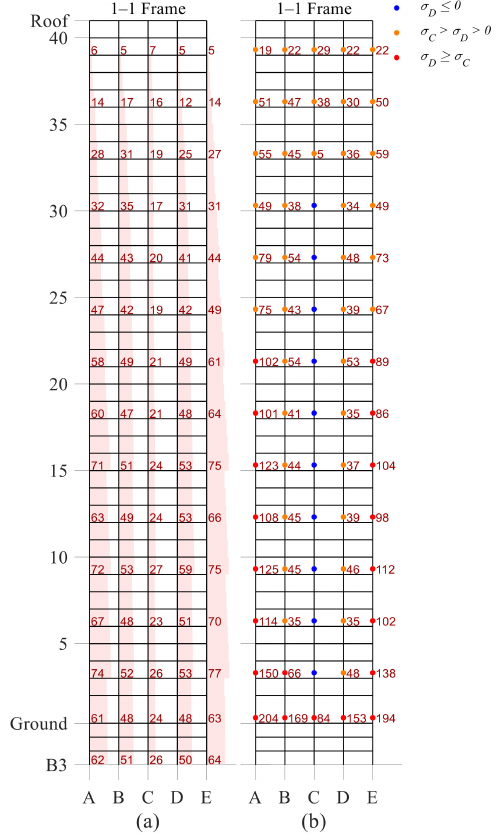
Figure 15. ( a ) Median column normalized peak compressive forces and median peak [%], ( b ) tensile stresses at column splices of the retrofitted building [MPa]